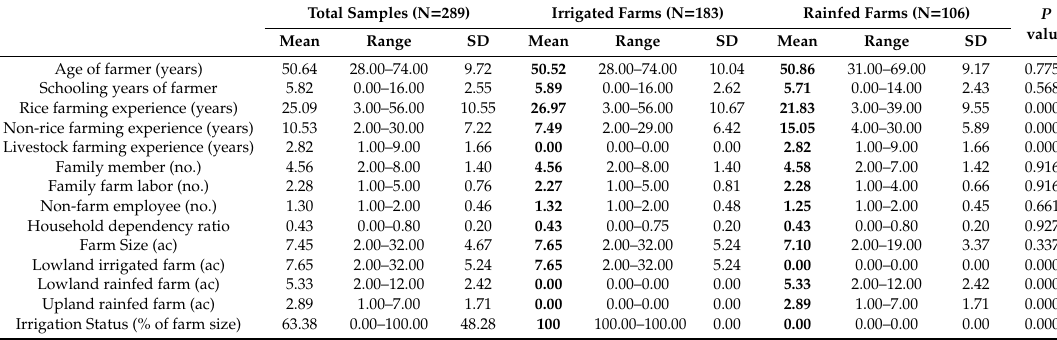
Table 3. Descriptive analysis on sample households’ profile.